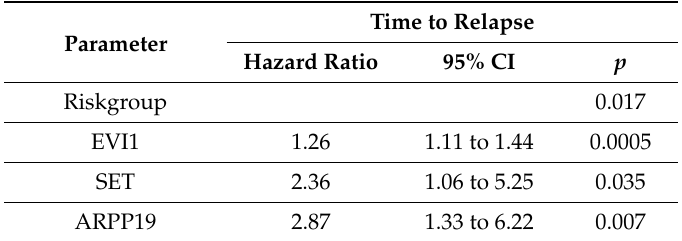
Table 1. Univariable analysis for time to relapse in entire patient cohort1.